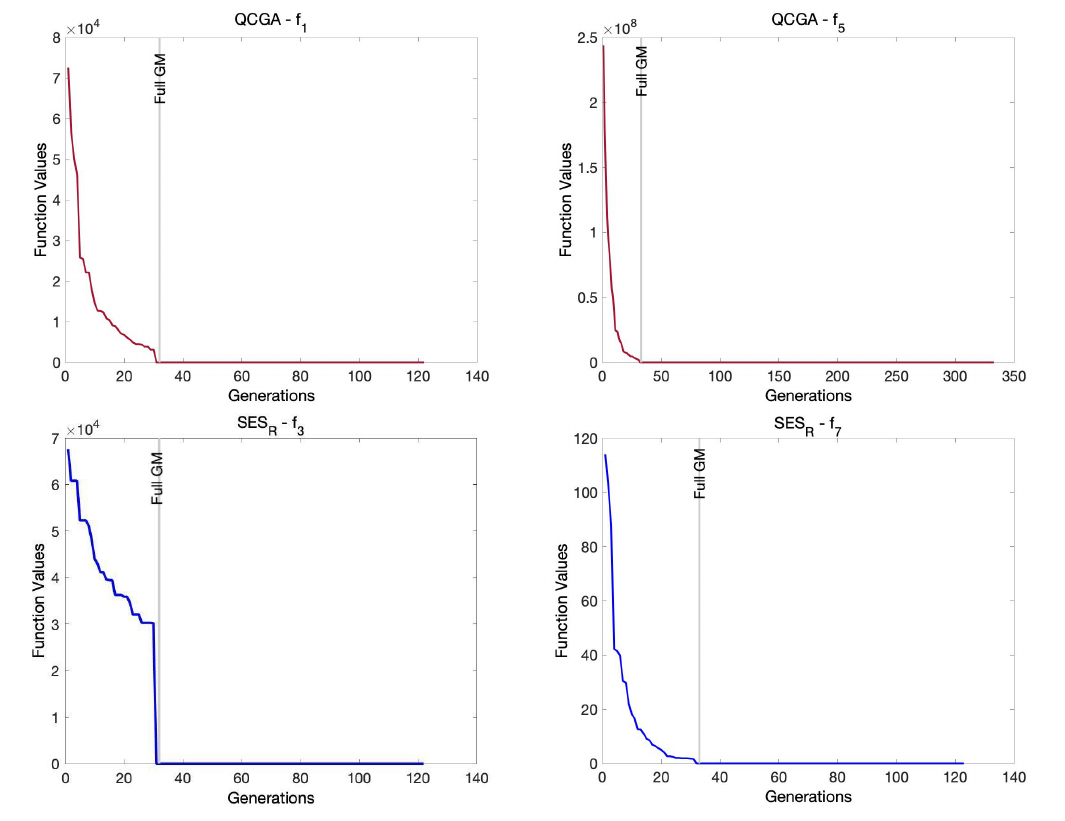
Figure 9. GM termination performance.